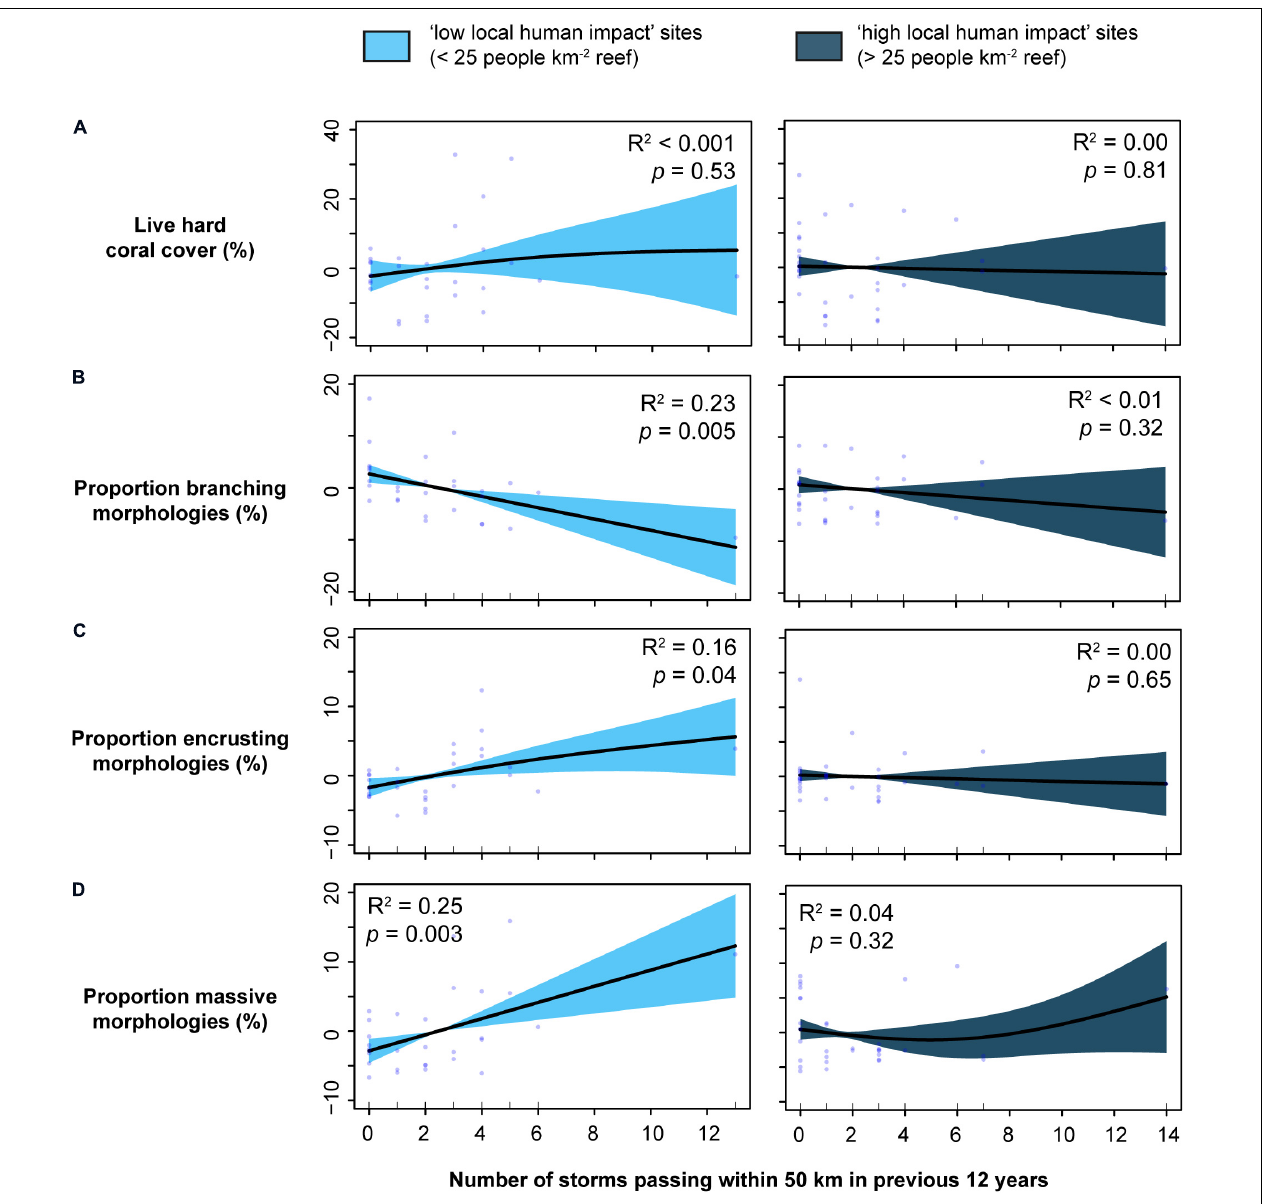
FIGURE 4 | Smoother plots of normalised residuals from generalised additive models with 95% confidence intervals (shaded areas) to exemplify discrepancies in response-predictor relationships between local impact levels, using storm exposure as an example. The plots represent the explanatory power of storm exposure in predicting (A) live hard coral cover, and the proportion of (B) branching, (C) encrusting, and (D) massive morphologies, separated for sites with low versus high local impacts. Refer to Supplementary Figure 6 for all predictor-response plots from best-fit